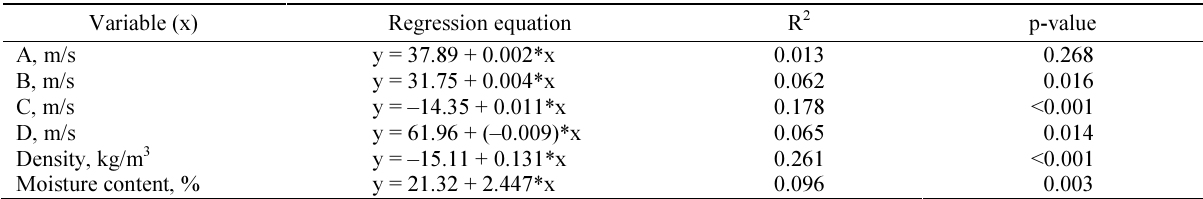
Table 5. Predicting bending strength (y) with different variables (x)